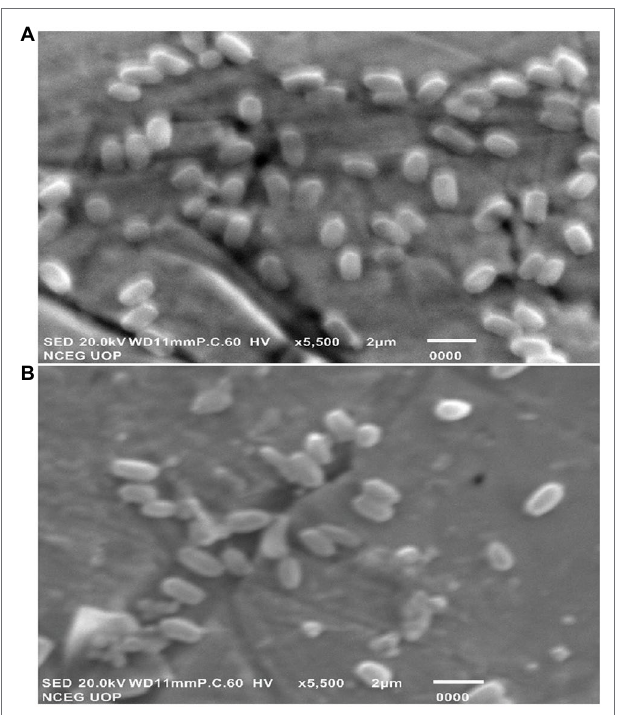
FIGURE 8 | SEM micrographs of B. altitudinis MT422188 (A) with (B) without Cu.